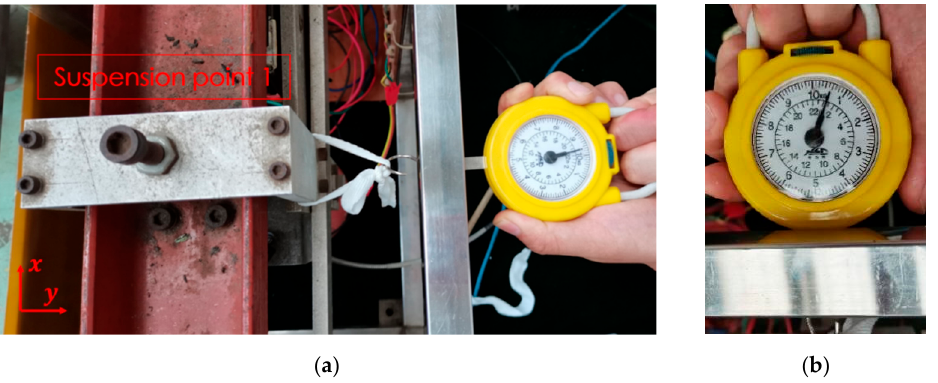
Figure 18. The experimental method in the small-scale experimental platform. ( a ) The nominal state; ( b ) the state existing horizontal misalignment.